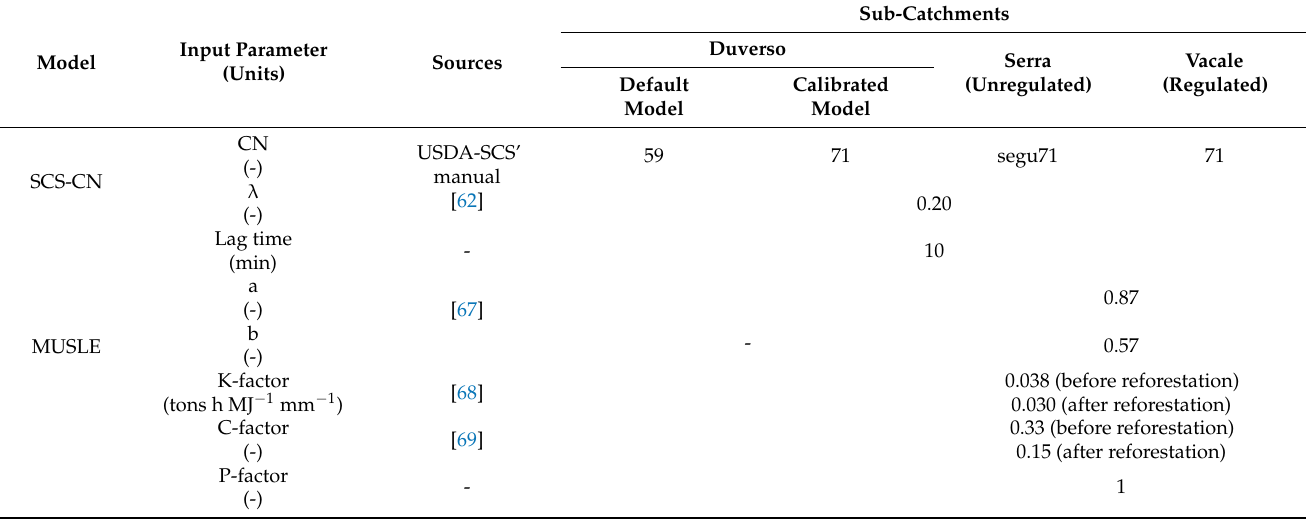
Table 3. Values of the input parameters adopted to simulate runoff and sediment yield using the HEC-HMS (SCS-CN method) and MUSLE models applied in the three sub-catchments (Calabria, Southern